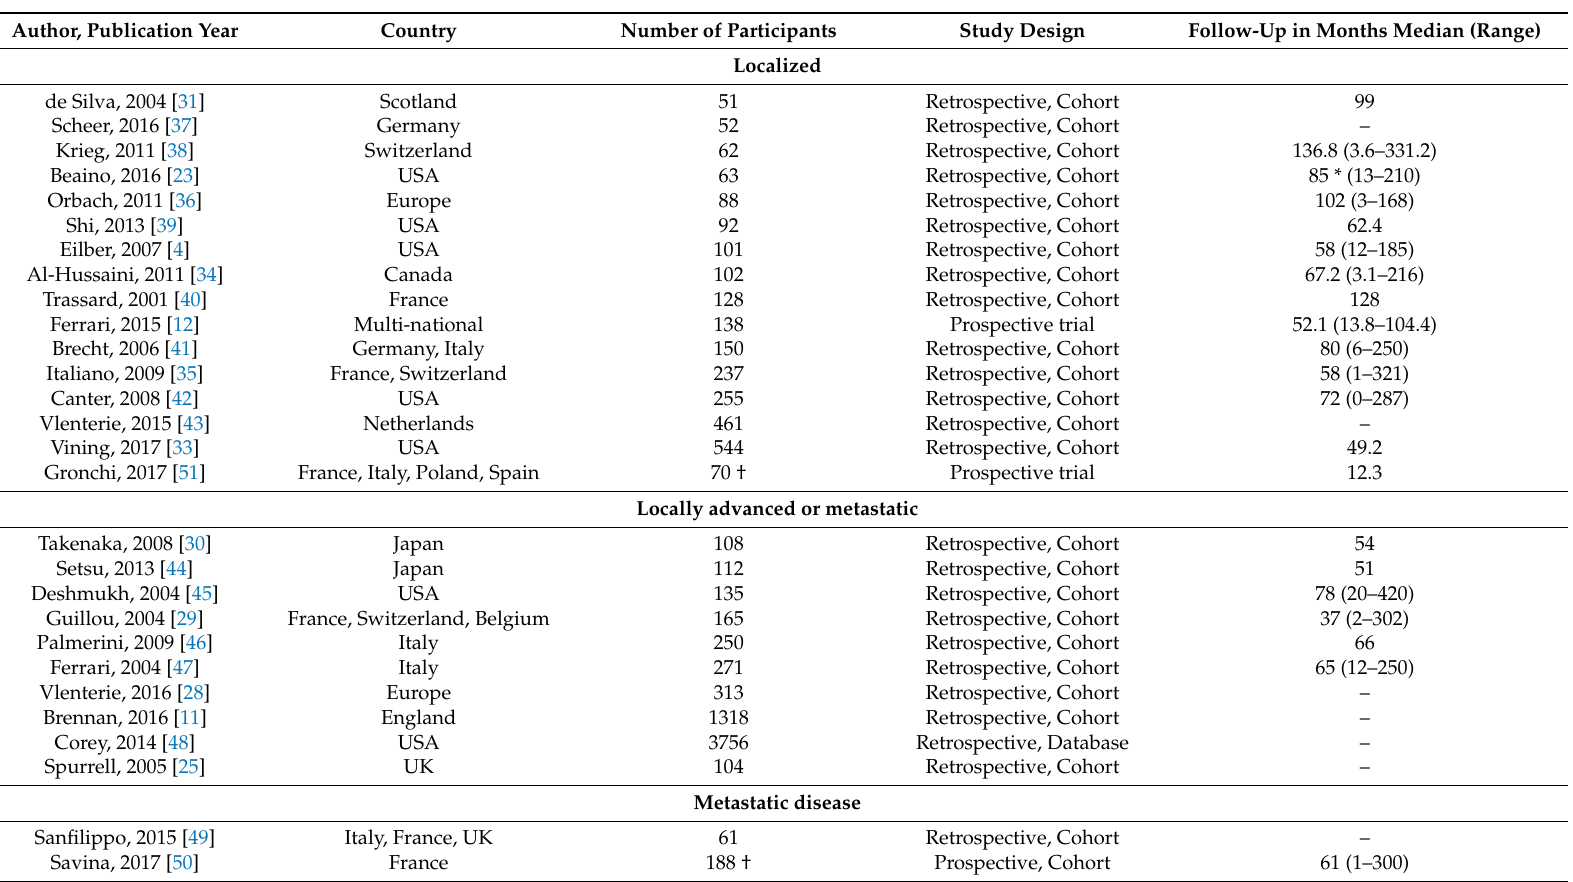
Table 2. Included studies and their